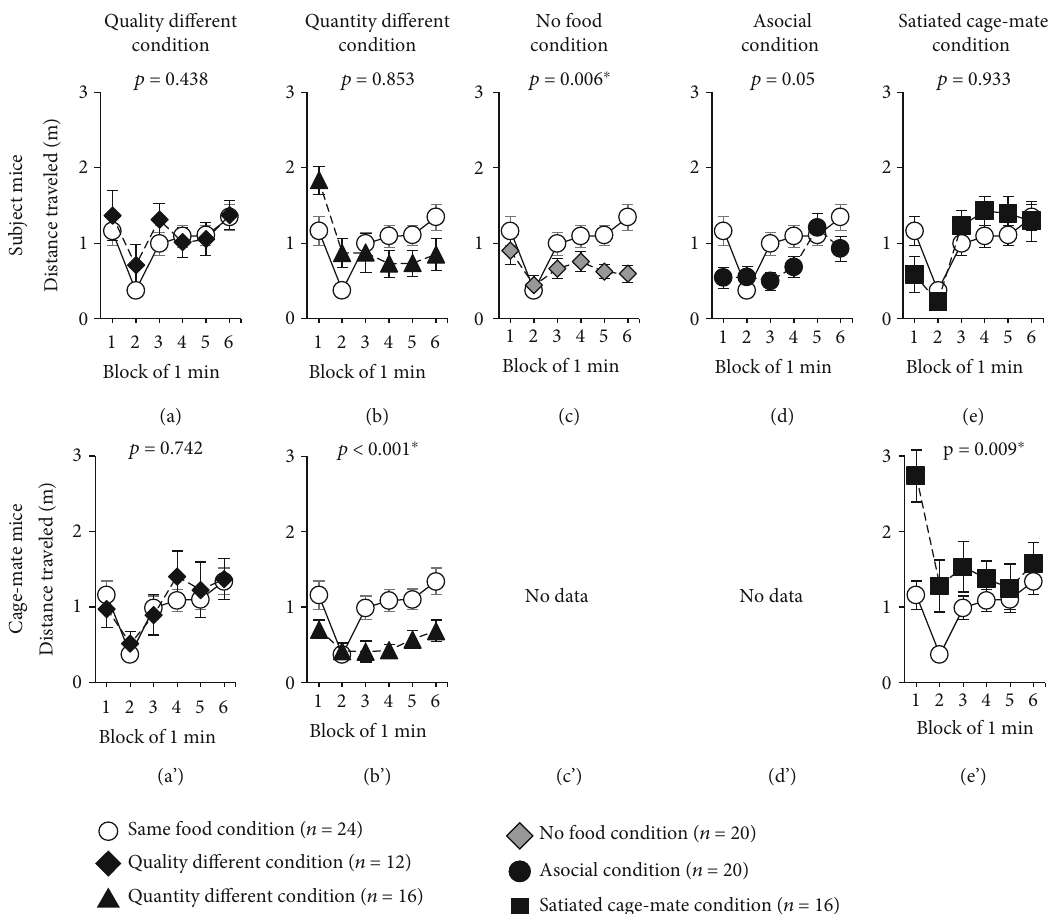
Figure 2: Comparison of the distance traveled per 1-minute period. Comparison of the distance traveled in each 1-minute period in various conditions of the feeding behavioral test (same food condition, n = 24 ; quality di ff erent condition, n = 12 ; quantity di ff erent condition, n = 16 ; no food condition, n = 20 ; asocial condition, n = 20 ; stu ff ed cage-mate condition, n = 16 ). The upper row shows the subject mice ((a) – (e)), and the lower row shows the cage-mate mice ((a ′ ) – (e ′ )). Data are presented as means ± SEM . Statistical signi fi cance is represented by asterisks: ∗ p < 0 : 05 . The p values were calculated by a two-way repeated measures